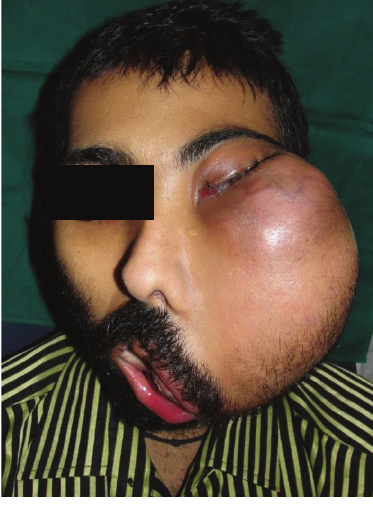
Figure 1: Frontal view.